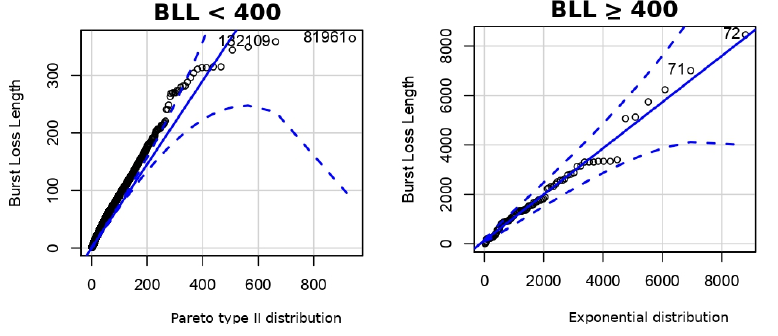
Figure 6. QQ-Plot for state G.